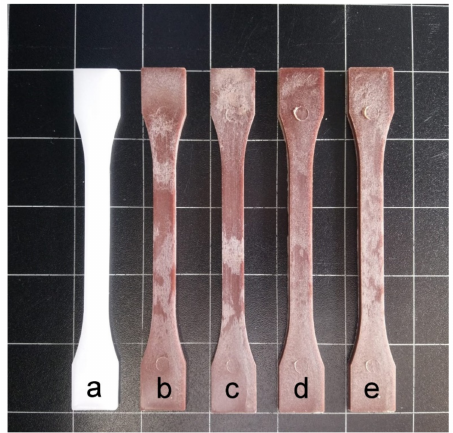
Figure 8. Visual appearance of the samples: ( a ) Bio-HDPE; ( b ) Bio-HDPE/PE-g-MA/MAS; ( c ) Bio-HDPE/PE-g-MA/MAS/HNT; ( d ) Bio-HDPE/PE-g-MA/MAS/MLO; ( e ) Bio-HDPE/PE-g-